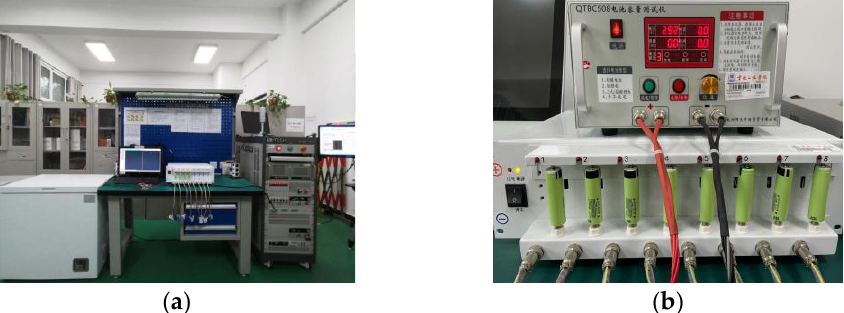
Figure 3. Battery pack test platform. Test platforms of 8 channel lithium battery test platform ( a ) and Lithium battery pack ( b ).